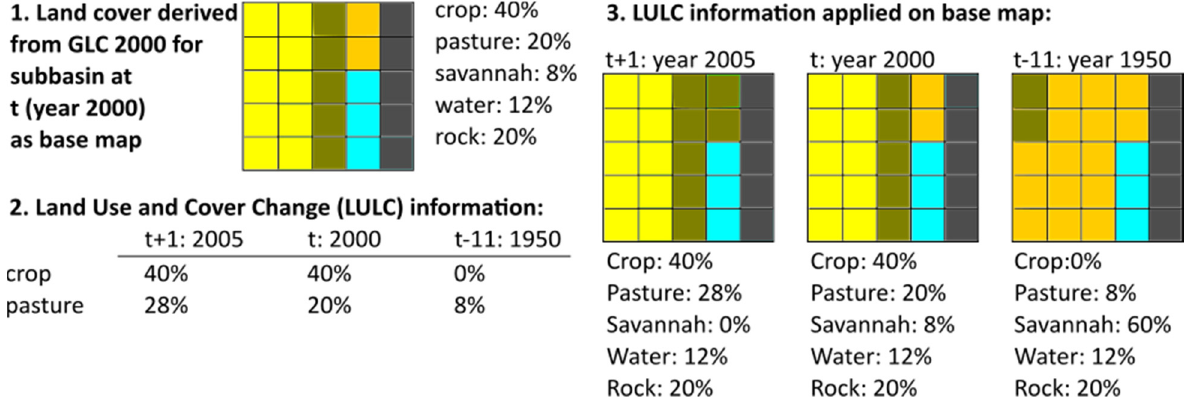
Figure 6. Exemplary process of how the information from the Land Use and Land Cover data of the Land-Use Harmonization project is used on the subbasin level to produce land cover maps for the different years which are then used by the land use change module. The whole square represents one exemplary subbasin, with small squares representing individual stable units